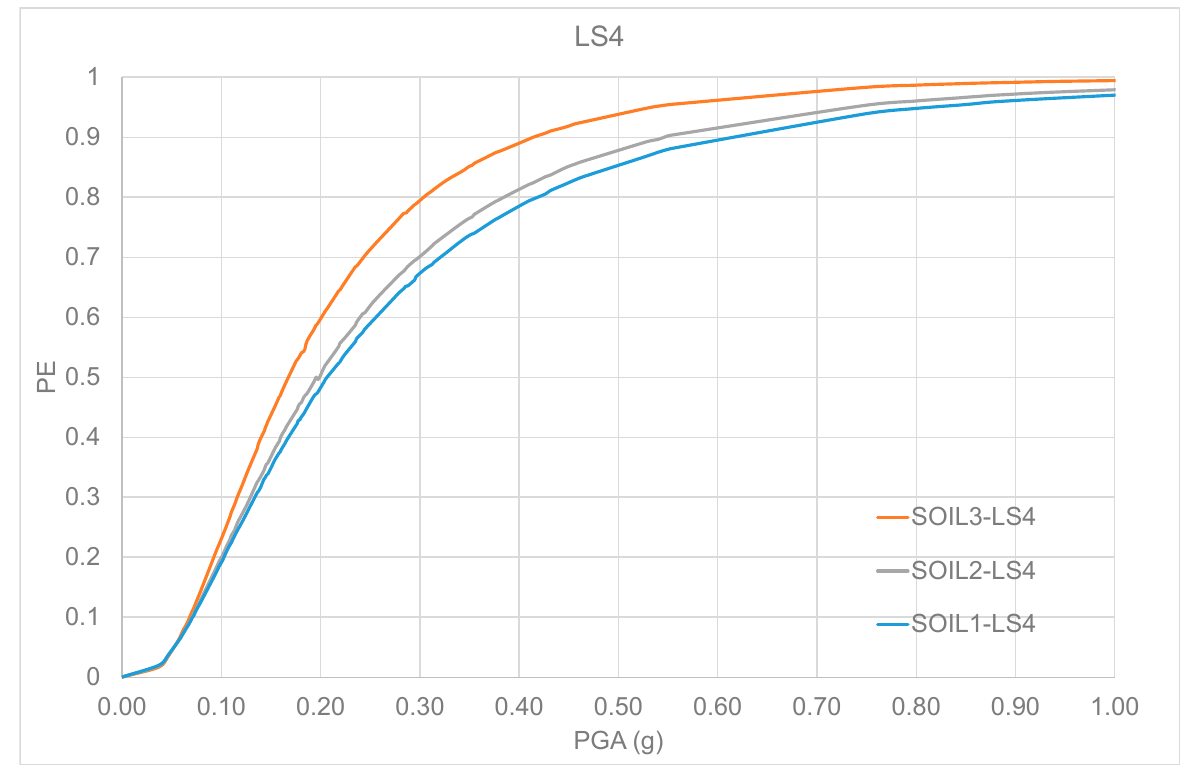
Figure 9. Fragility Curves: comparison LS1.